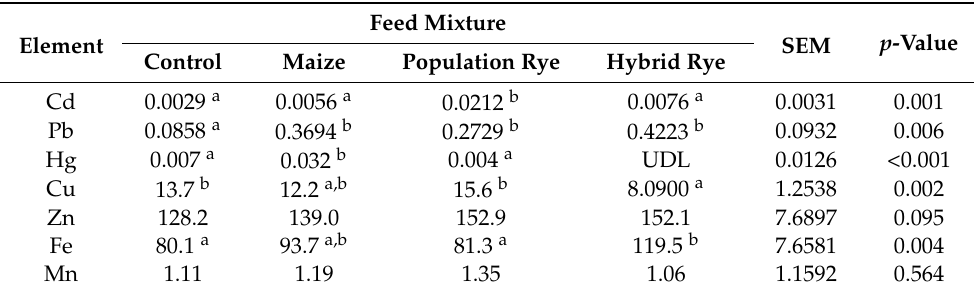
Table 6. The mean content of heavy metals (mg/kg dry tissue, b. wt.) in the muscles of pigs fed control and experimental diets.